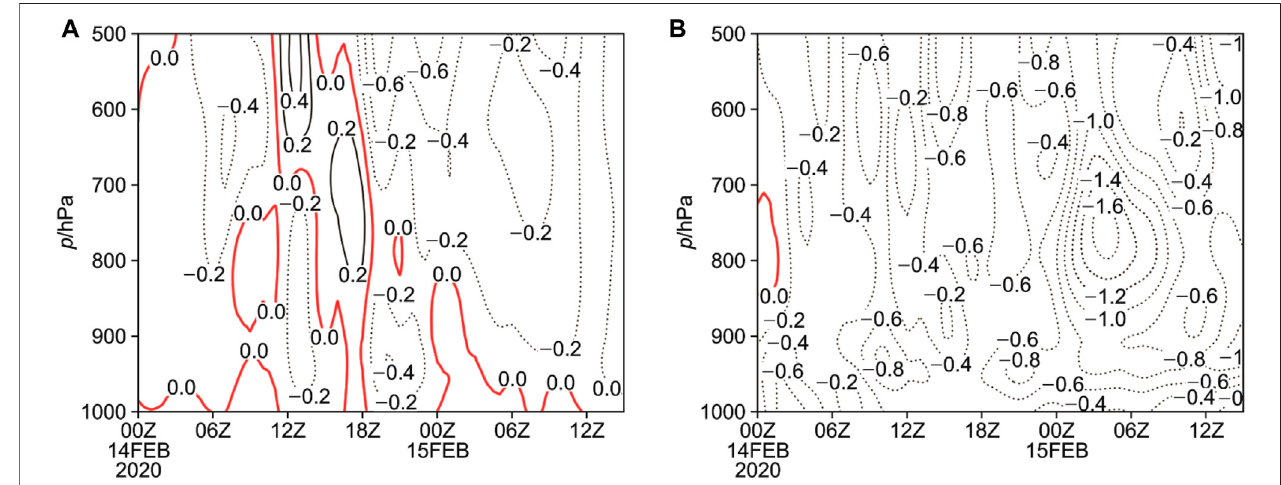
FIGURE 10 | Uplift movement at Zhangwu (A) and Huanren (B) stations with time and latitude (unit: hPa/s).